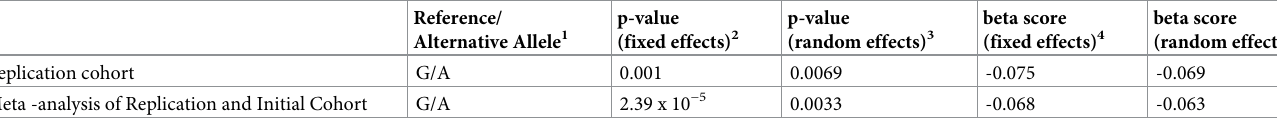
Table 2. Results for genetic association of rs1078761 with CF lung disease